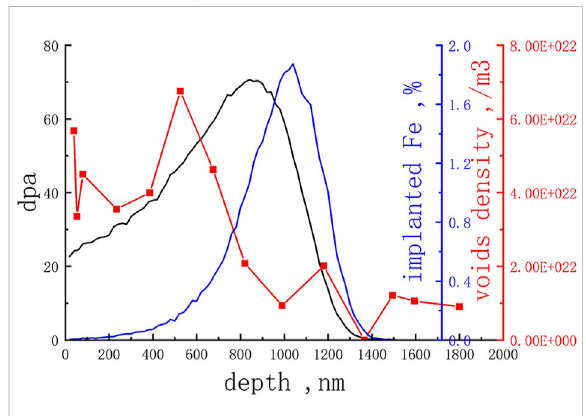
FIGURE 12 Distribution of voids density along depth with the irradiation damage and implanted ions distribution calculated by